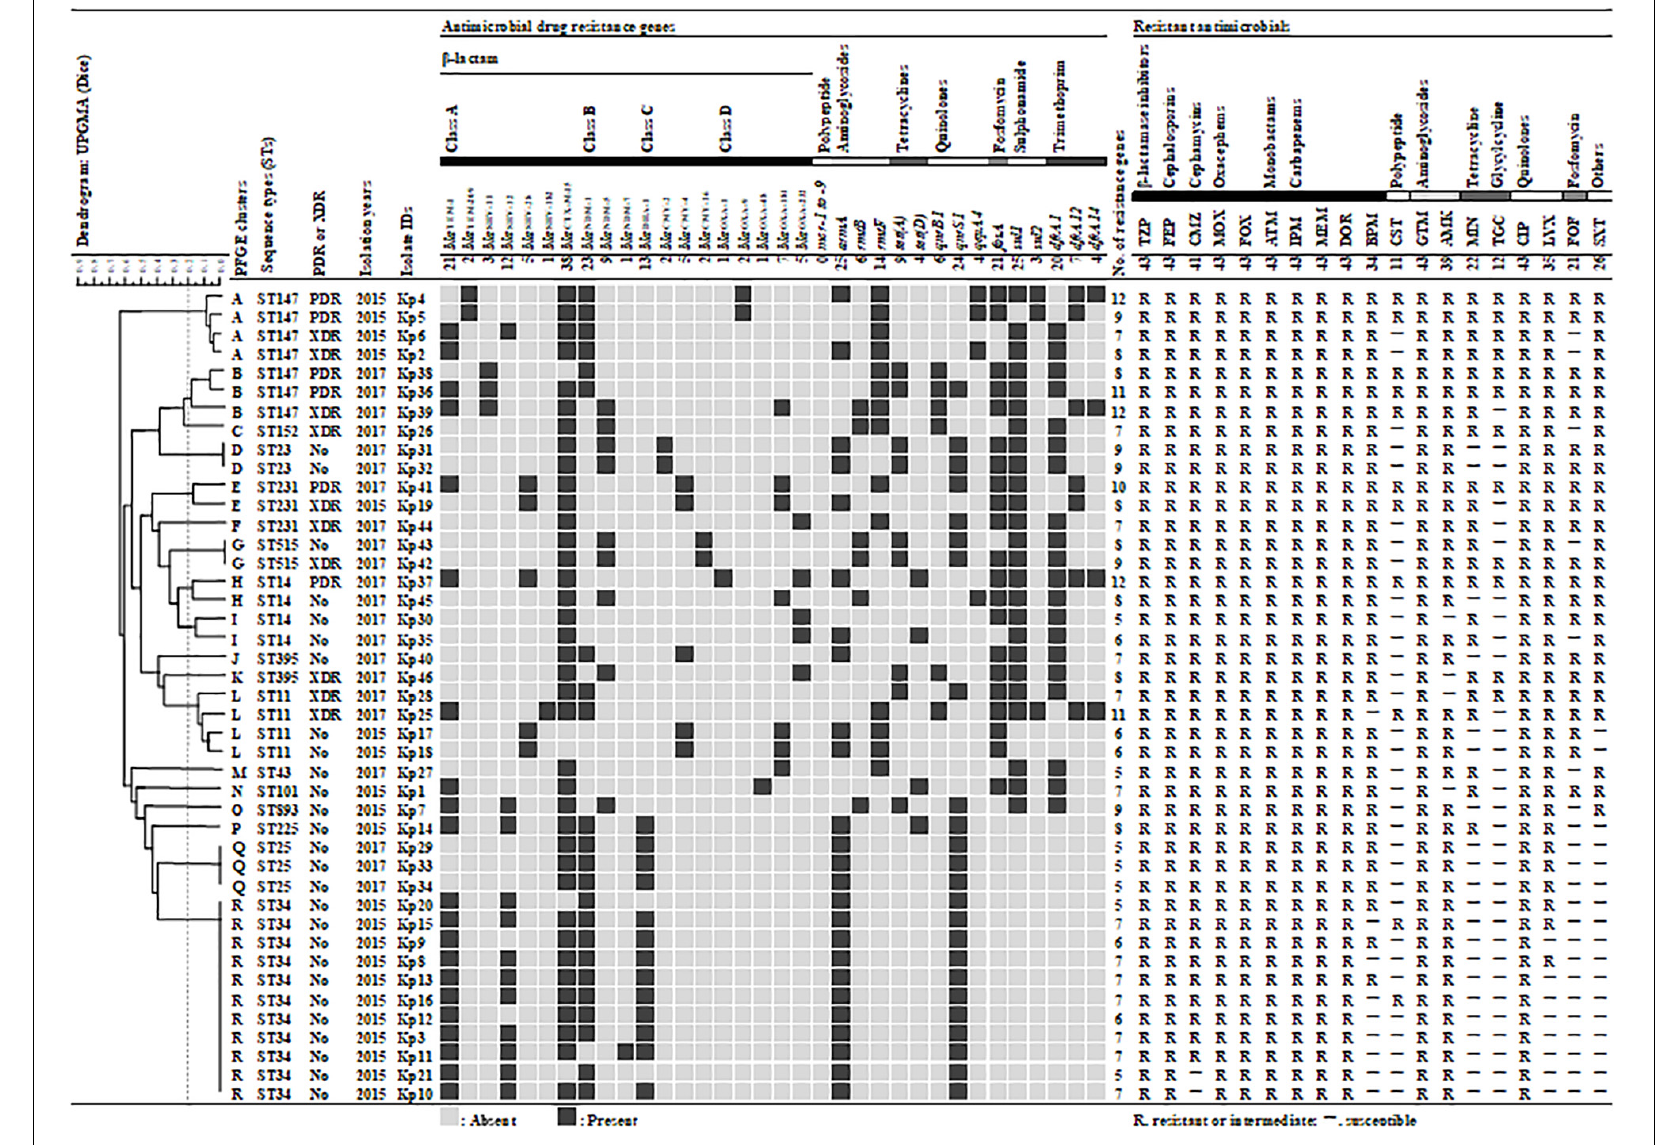
FIGURE 1 | Genetic and antibiogram profiles of 43 carbapenemase-producing Klebsiella pneumoniae isolates. A similarity coefficient of 80% was selected to define the clusters after reviewing the epidemiological data associated with each of the clusters of isolates. The presence or absence of plasmid-mediated antimicrobial resistance genes is indicated by black filled square or gray filled square, respectively. Antimicrobial susceptibility: susceptible (S) and resistant/intermediate (–). TZP, piperacillin/tazobactam; FEP, cefepime; CMZ, cefmetazole; MOX, moxalactam; FOX, flomoxef; ATM, aztreonam; IPM, imipenem; MEM, meropenem; DOR, doripenem; BPM, biapenem; CST, colistin; GEN, gentamicin; AMK, amikacin; MIN, minocycline; TGC, tigecycline; CIP, ciprofloxacin; LVX, levofloxacin; FOF, fosfomycin; SXT,